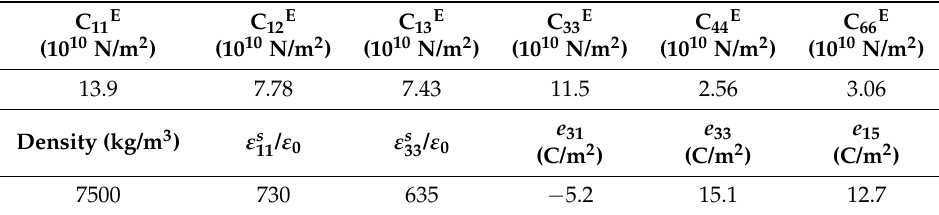
Table A1. Material properties of piezoelectric ceramic